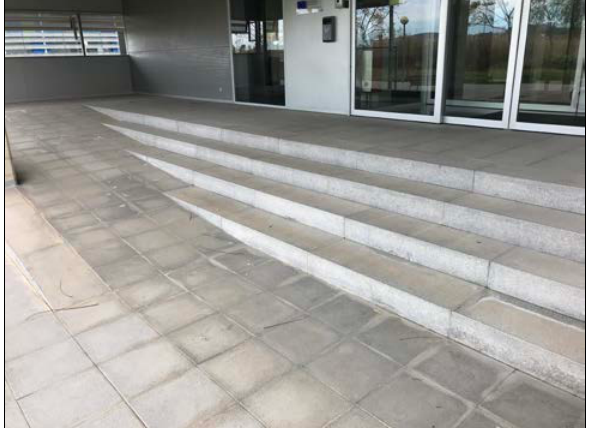
Figure 6. Stairs and ramp scenario.